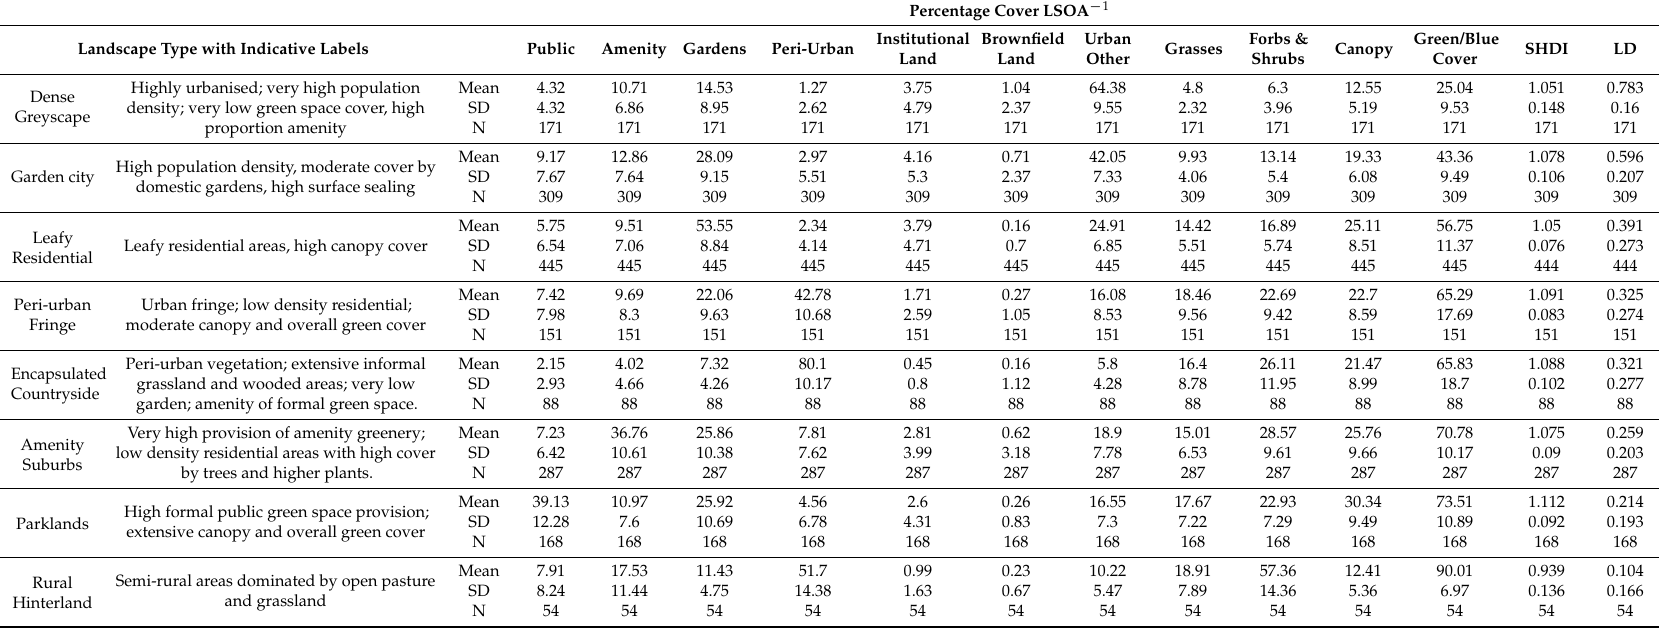
Table 4. Description and basic characteristics of landscape types generated for the case study